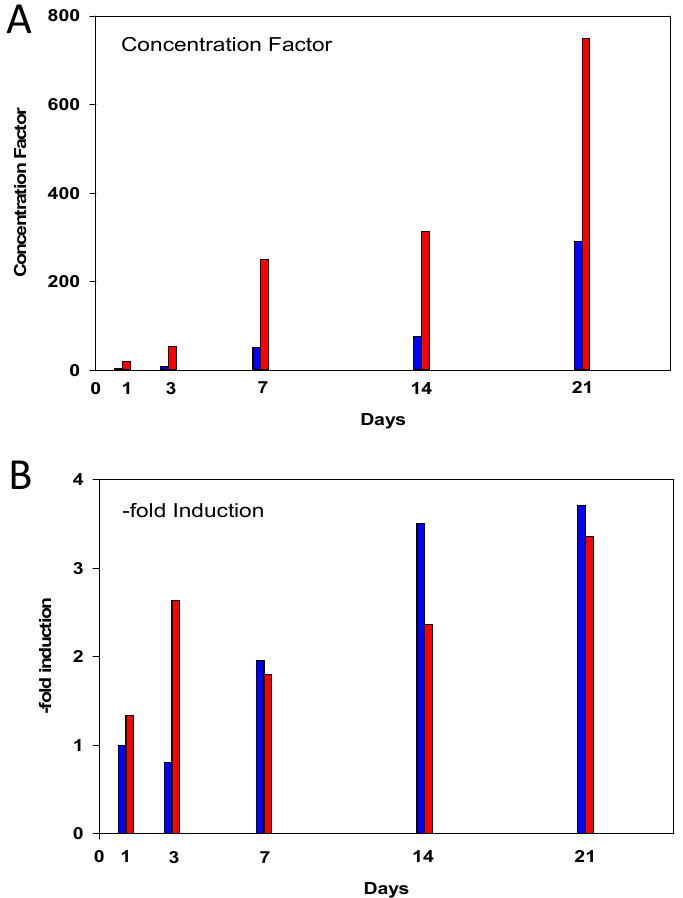
Figure 4. ( A ) Concentration factor for Cd in the midgut gland of Littorina littorea . Blue bars represent the low Cd exposure group (CdL), the red bars represent the high Cd exposure group (CdH). All values refer to respective control concentrations at the beginning of the experiment; ( B ) Fold induction factor for the increase of the MT mRNA concentration. Blue bars represent the low Cd exposure group (CdL). Red bars represent the high Cd exposure group (CdH). All values refer to the respective control mRNA copy numbers at the beginning of the experiment (set to 1).